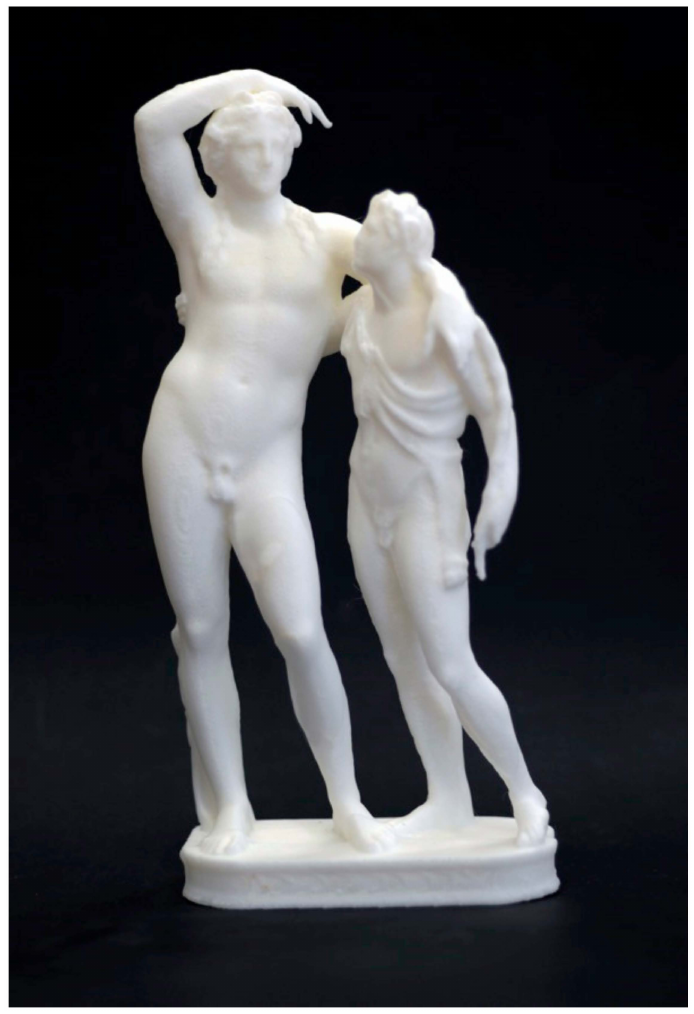
Figure 18. The fused deposition modeling (FDM) replica (a scale of